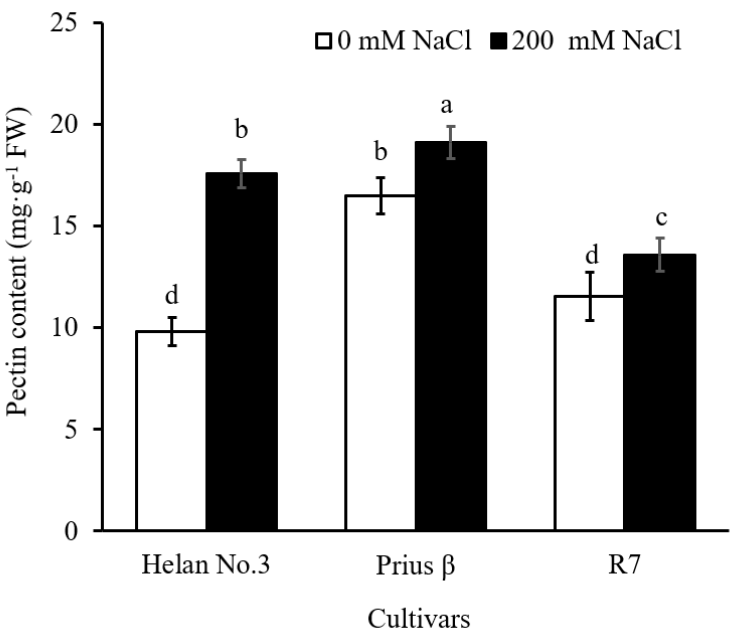
Figure 3. Pectin contents in root cell wall in three cultivars, Helan 3, Prius β and R7, under 0 and 200 mM NaCl treatments. Data are mean ± S.E. ( n = 6). Different letters indicate significant differences ( p <